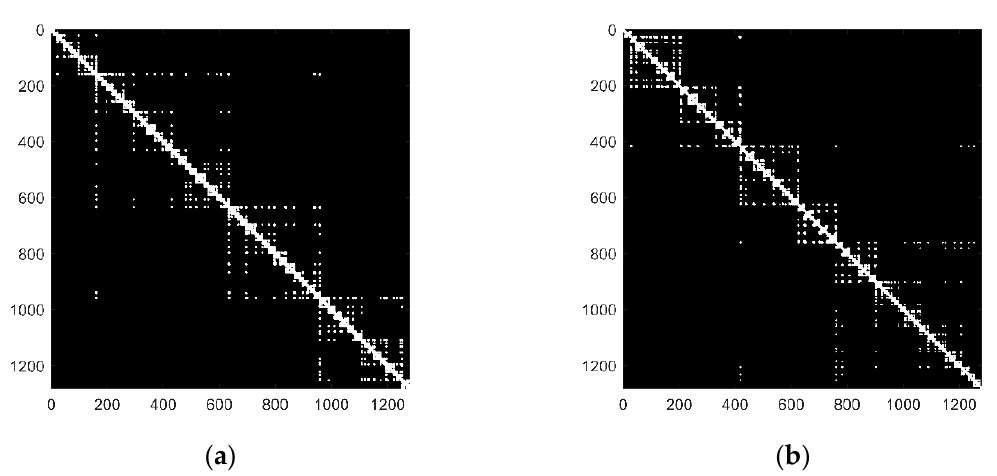
Figure 5. The adjacency matrix of networks based on VG. ( a ) EEG series with low valence; ( b ) EEG series with high valence.